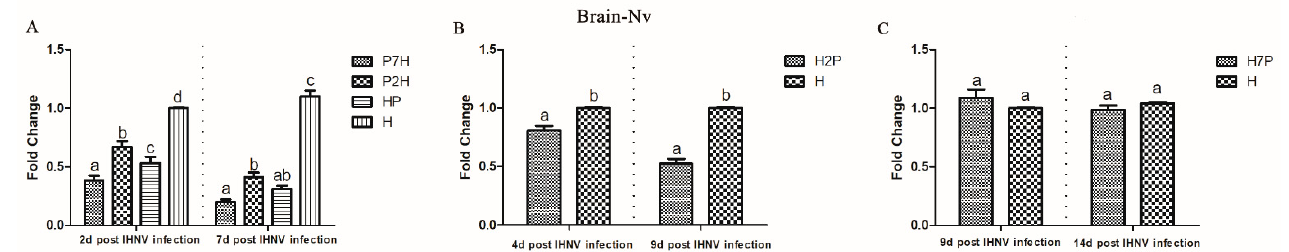
Figure 3 . IHNV Nv genes in the brain determined by qRT-PCR. Rainbow trout challenged with IHNV (group H) were used as controls. Different letters on the bar charts indicate statistically significant differences ( p < 0.05). ( A ) The levels of IHNV Nv gene in groups P7H, P2H, and HP. ( B ) The levels of IHNV Nv gene in group H2P. ( C ) The levels of IHNV Nv gene in group H7P.